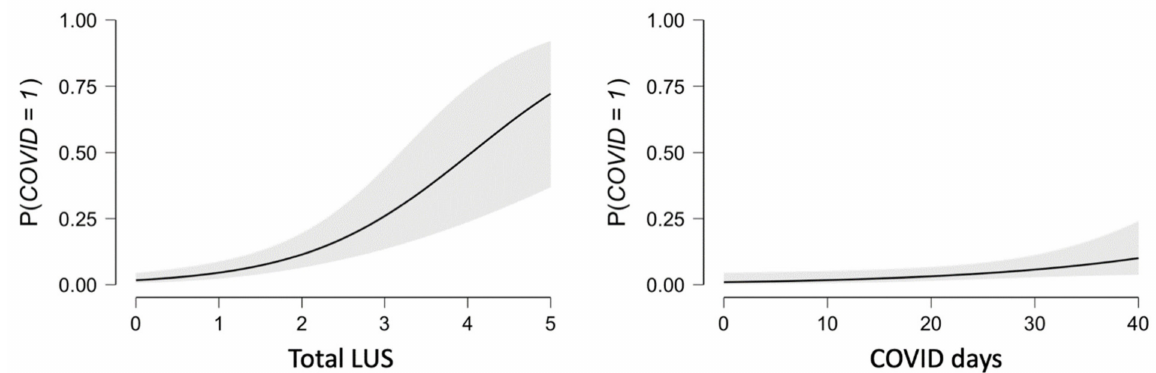
Figure 6. Logarithmic relationship between total LUS and COVID-19 positivity, and days worked in a COVID-19 ward (COVID days) and COVID-19 positivity.; COVID 0 = negative, COVID 1 = positive.